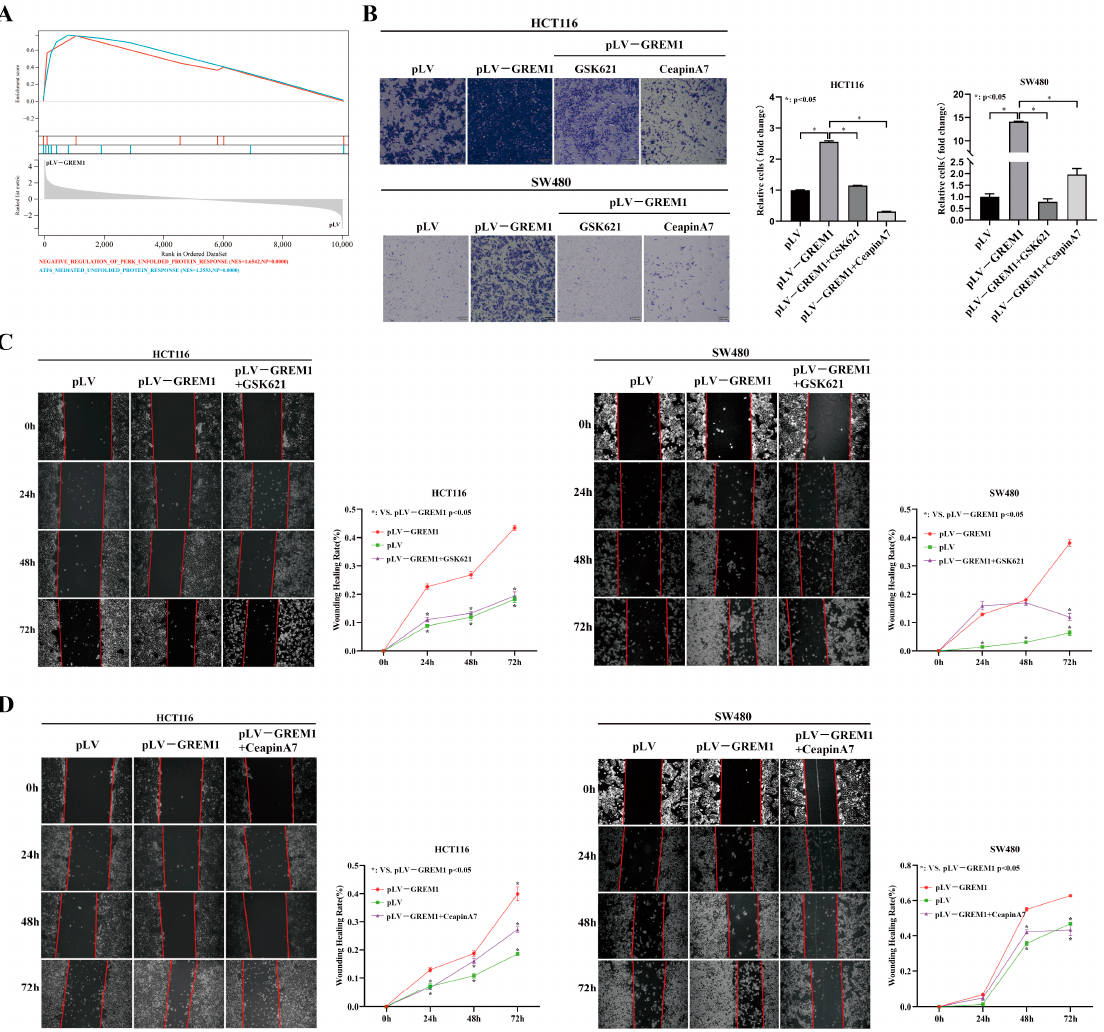
Figure 4. CeapinA7 and GSK621 inhibit GREM1-induced CRC cell line invasion and migration . ( A ) The GSEA was performed using an in-house RNA-seq dataset to identify gene sets in the KEGG collections that have positive correlations with GREM1 expression. The negative regulating PERK- mediated UPR (NES = 1.6542 NP = 0.0000) and ATF6-mediated UPR signaling pathway (NES = 1.3553, NP = 0.0000) with GREM1 overexpression in HCT116 cells. ( B ) HCT116 pLV-GREM1 and SW480 pLV-GREM1 cells were seeded into Matrigel-coated inserts with medium containing CeapinA7 (16 μ M) or GSK621 (30 μ M) and incubated for 36 h, followed by the invasion assay. ( C , D ) Wound healing test revealed that CeapinA7 and GSK621 inhibited cell migration.